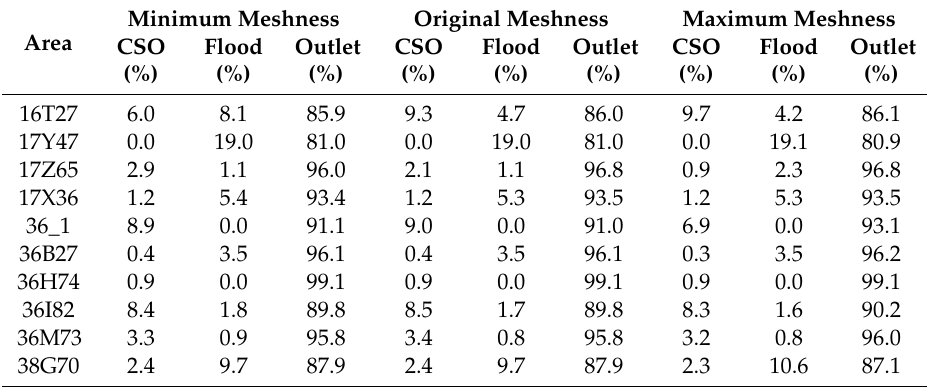
Figure 2. ( A ) Average number of CSO events per year (N CSO ), annual mean volumes (AMV) and annual mean loads (AML) for all CSOs in the reference conditions, and ( B ) Relative di ff erences of N CSO , AMV and AML in percentage among scenarios, including the di ff erence of meshness among them ( ∆ M). Table 4. Percentage distribution of water pathways for each studied area and each analyzed meshness